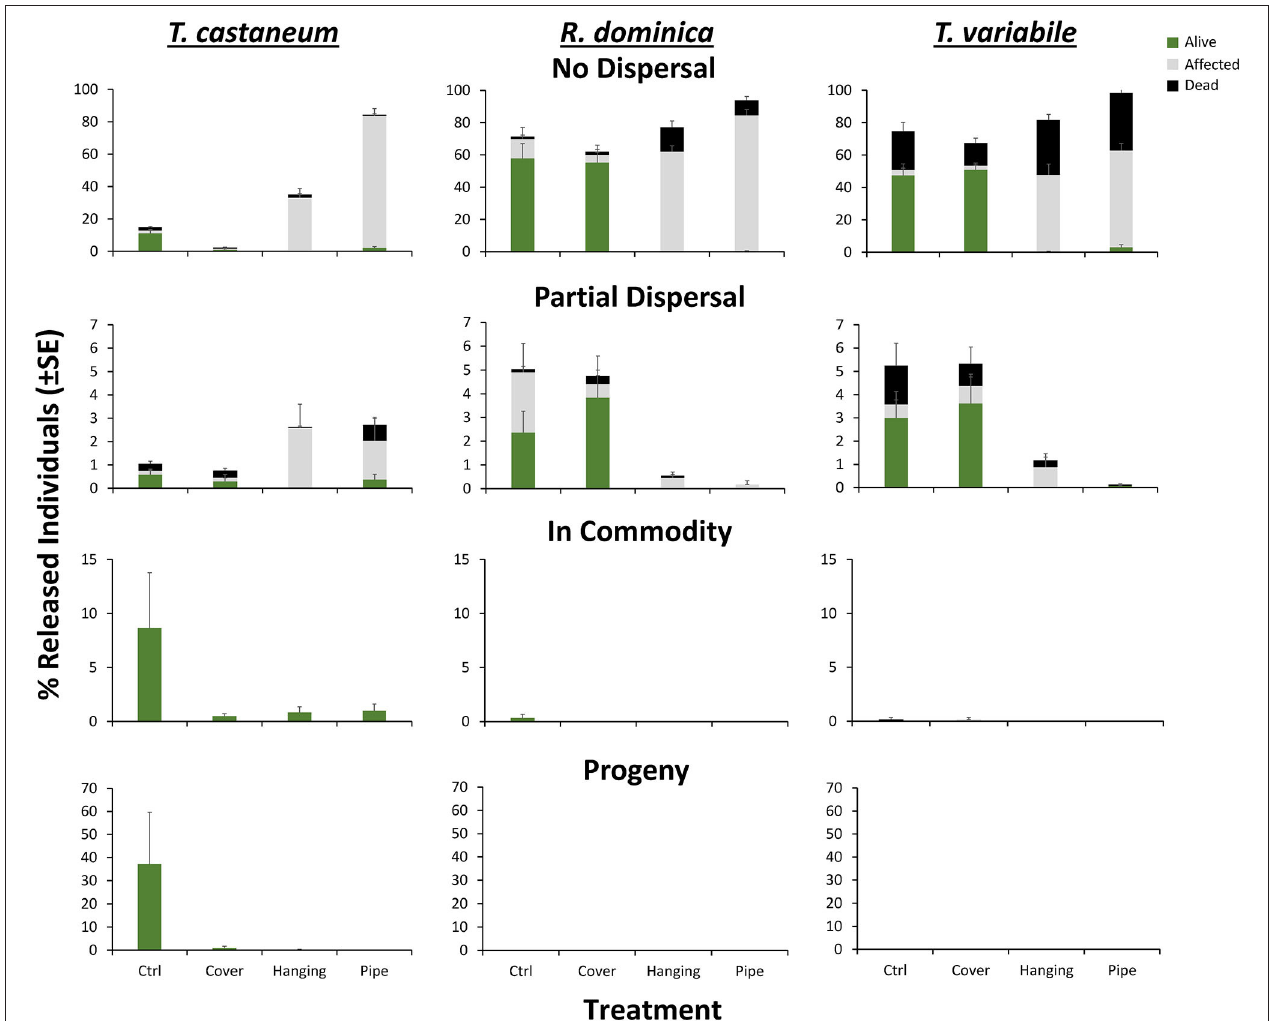
FIGURE 9 | Mean ( ± SE) percentage of 100 T. castaneum (left column), R. dominica (middle), and T. variabile (right) recaptured that were classified as alive (green), affected (gray), or dead (black) after dispersing 72h in pilot-scale warehouses with different methods of LLIN deployment in Manhattan, KS during 2019. Individuals were recorded as not dispersing (Zone 6, top row), partially dispersing (Zones 2–5, second row), infesting the commodity (Zone 1, third row), or producing progeny after a 6-week holding period (bottom row). Deployment methods included: Cover—covering the commodity directly with LLIN, Hanging—a single piece of LLIN bisecting the warehouse, Pipe—a piece of LLIN bisecting a PVC pipe with adults released in the pipe, and Ctrl—no deployment of LLIN. Bars with shared letters are not significantly different from each other (Tukey HSD, α =